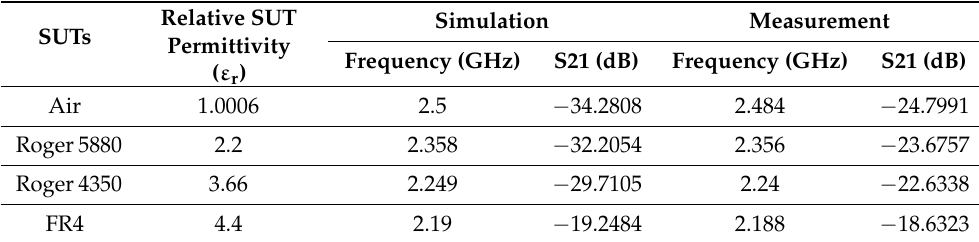
Figure 15. Comparison of simulated and measured curve-feed CSRR sensor with the presence of solid samples.